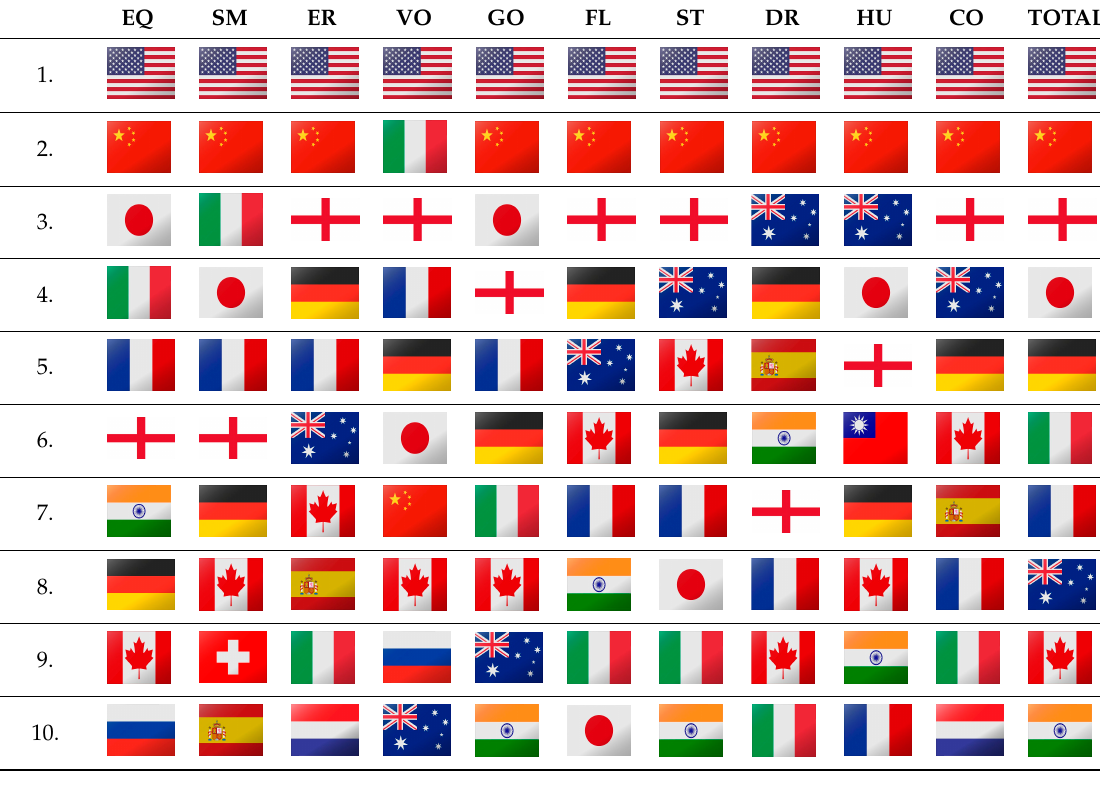
Table 4. Top 10 research countries for individual types of natural hazard (see Table 1 for abbreviations).